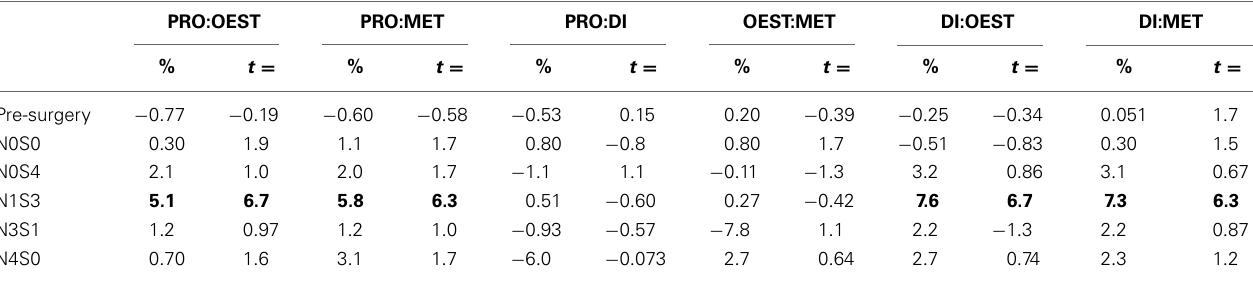
Table 2 | Traditional statistical analysis at the independent 2g von Frey Filament for von Frey Test 2 revealed the absence of an oestrus cycle effect prior to nerve injury (Pre-Surgery).